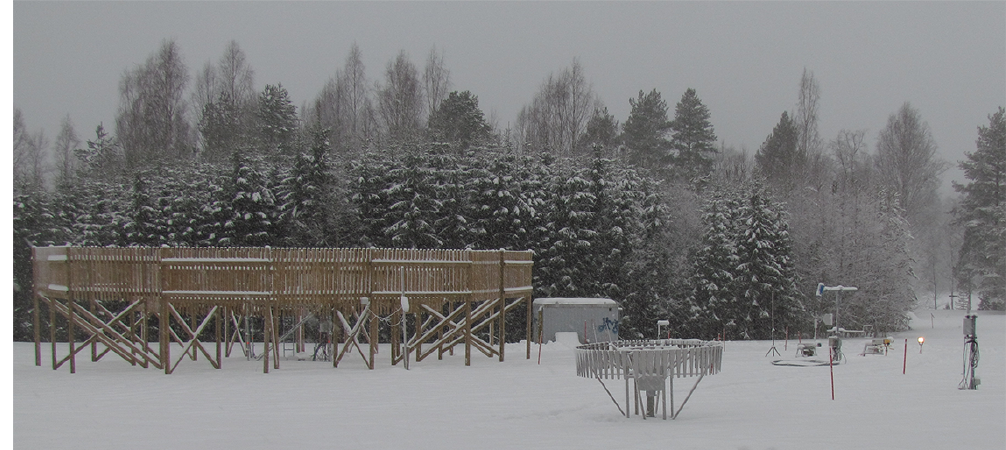
Figure 1. Snow precipitation instruments on the measurement field in Hyytiälä. The Pluvio 2 200 is inside the wind protection on a platform and the PIP lamp can be seen at right on the ground. The view of the picture is to southwest and the distance from the platform to the treeline behind is approximately